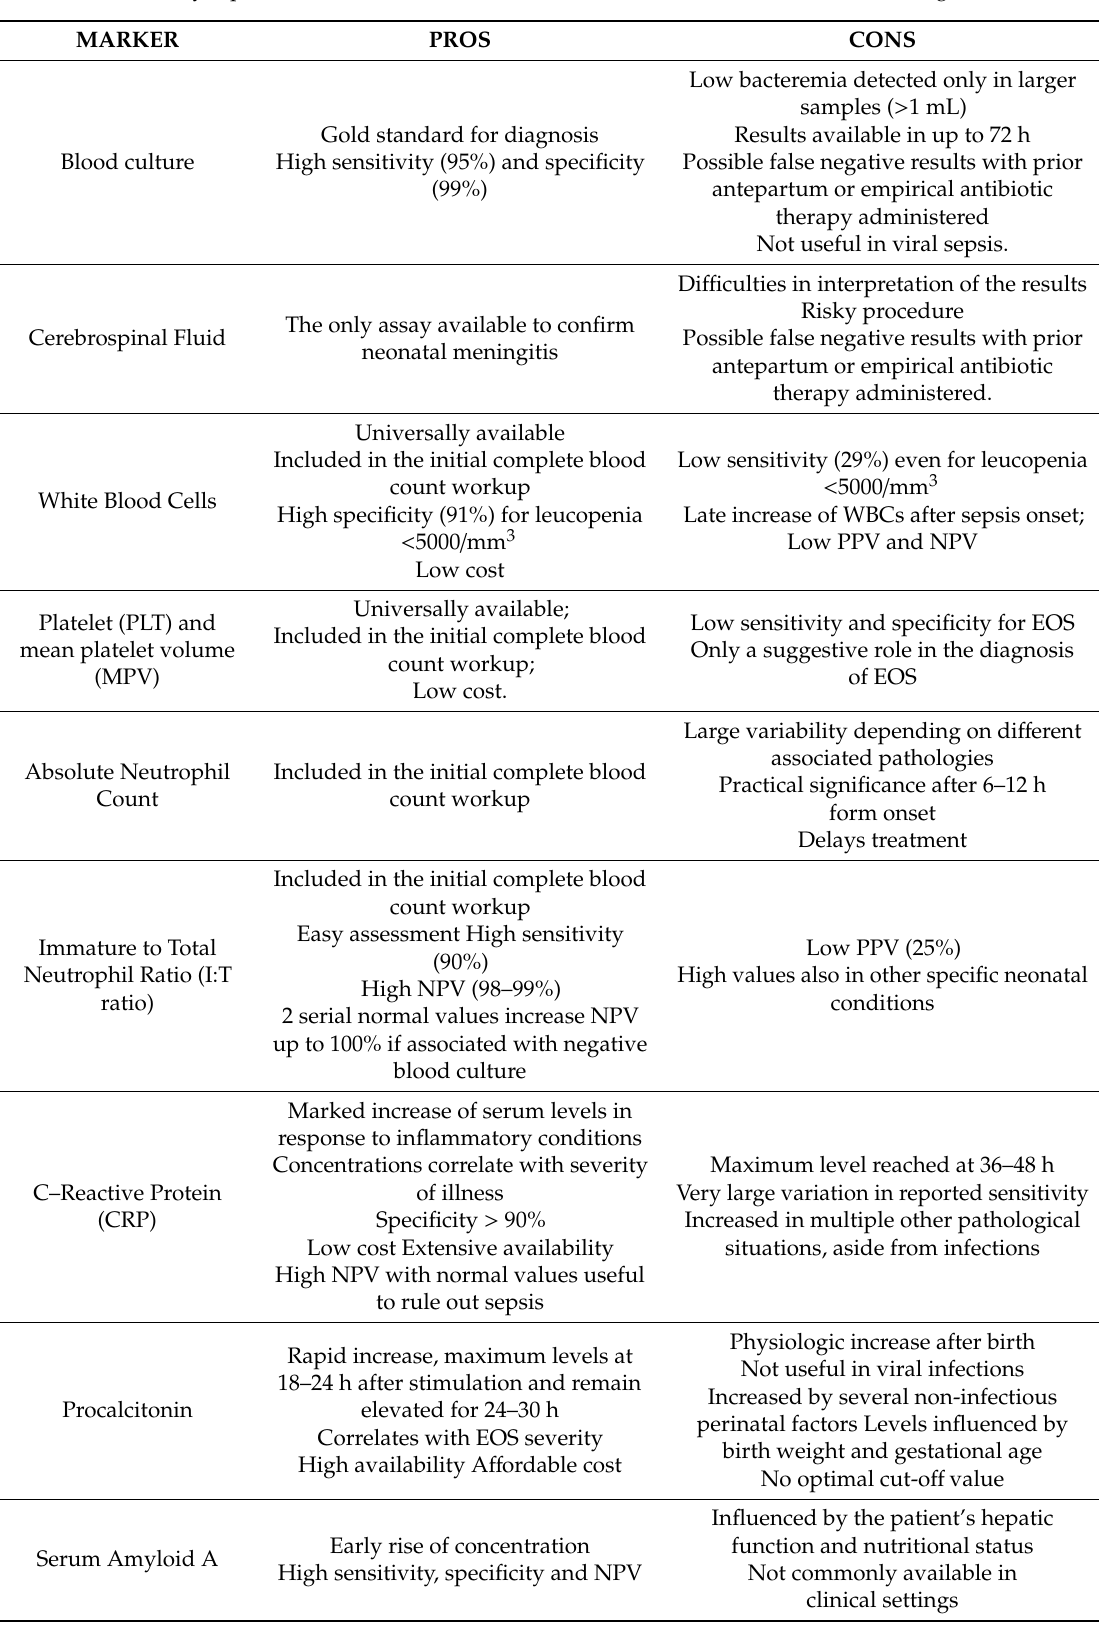
Table 3. Synopsis of the main characteristics of the discussed biomarkers for EOS diagnosis.